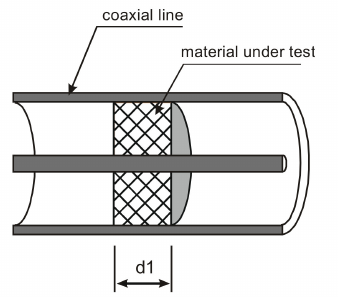
Figure 2. Configuration of material sample in the coaxial